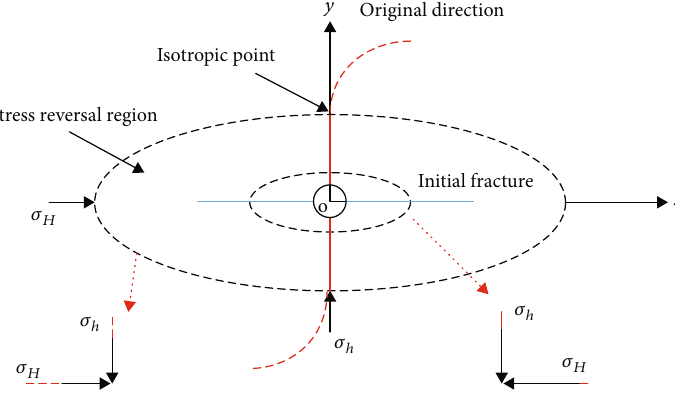
Figure 7: Diagram of stress reversal region and fracture reorientation in refracturing